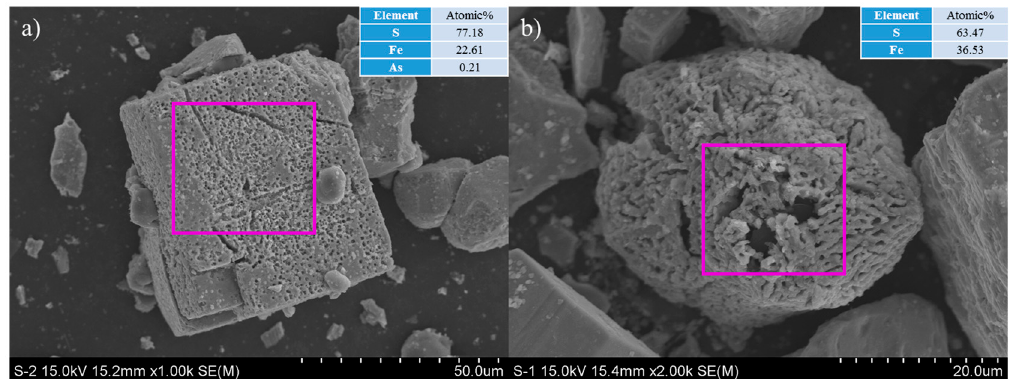
Figure 12. SEM images of leach residues. The leaching conditions were 80 °C, 15 min, and HNO 3 concentration of ( a ) 0.1 M and ( b ) 0.5 M.